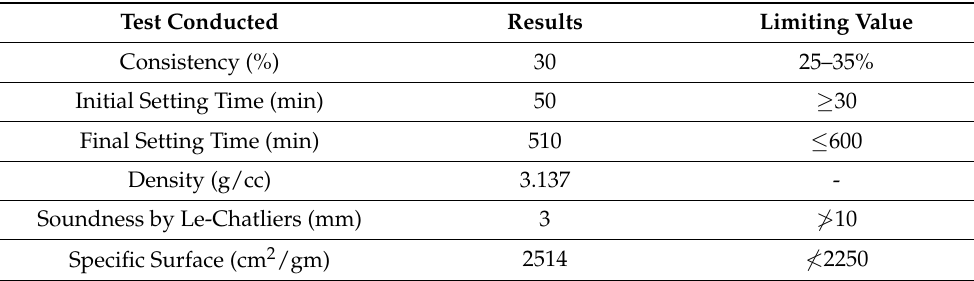
Table 1. Physical Characteristics of Cement.